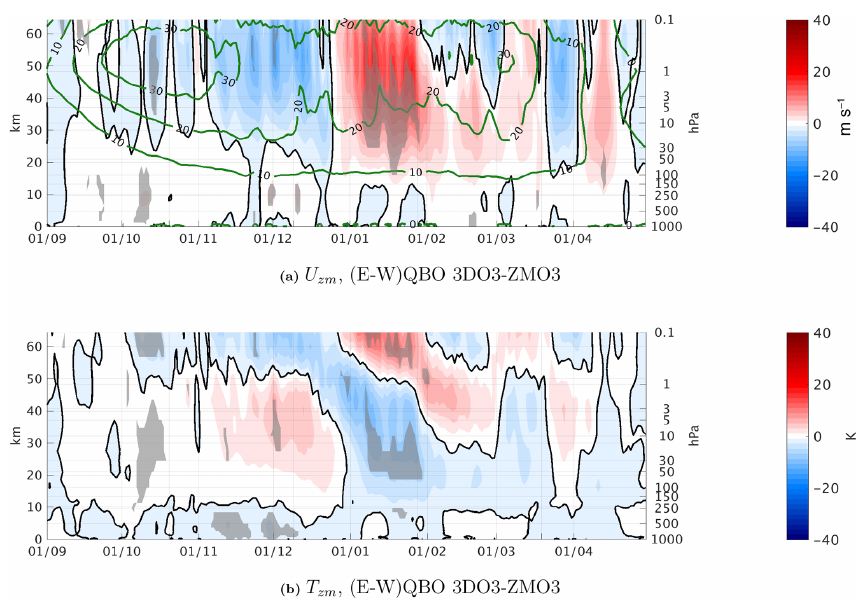
Figure A1. Daily climatology east–west QBO differences between the 3DO 3 and ZMO 3 model runs of the zonal mean zonal wind averaged over 75–55 ◦ N (a) and the zonal mean temperature averaged over 90–66 ◦ N for the 3DO 3 (b) for September–March. Statistically significant areas are shown by gray